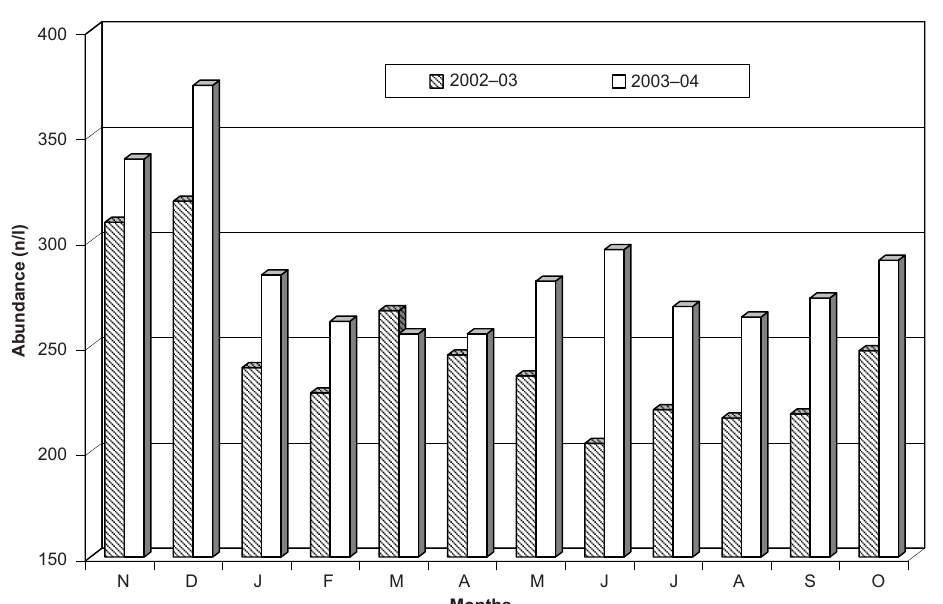
Figure 5. Monthly variations in abundance of zooplankton